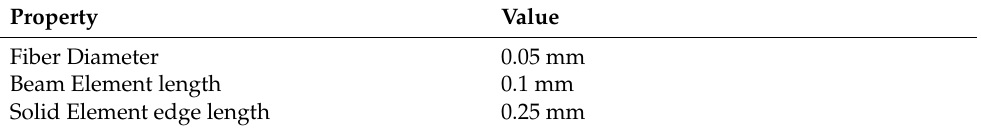
Table 3. Finite element model properties.